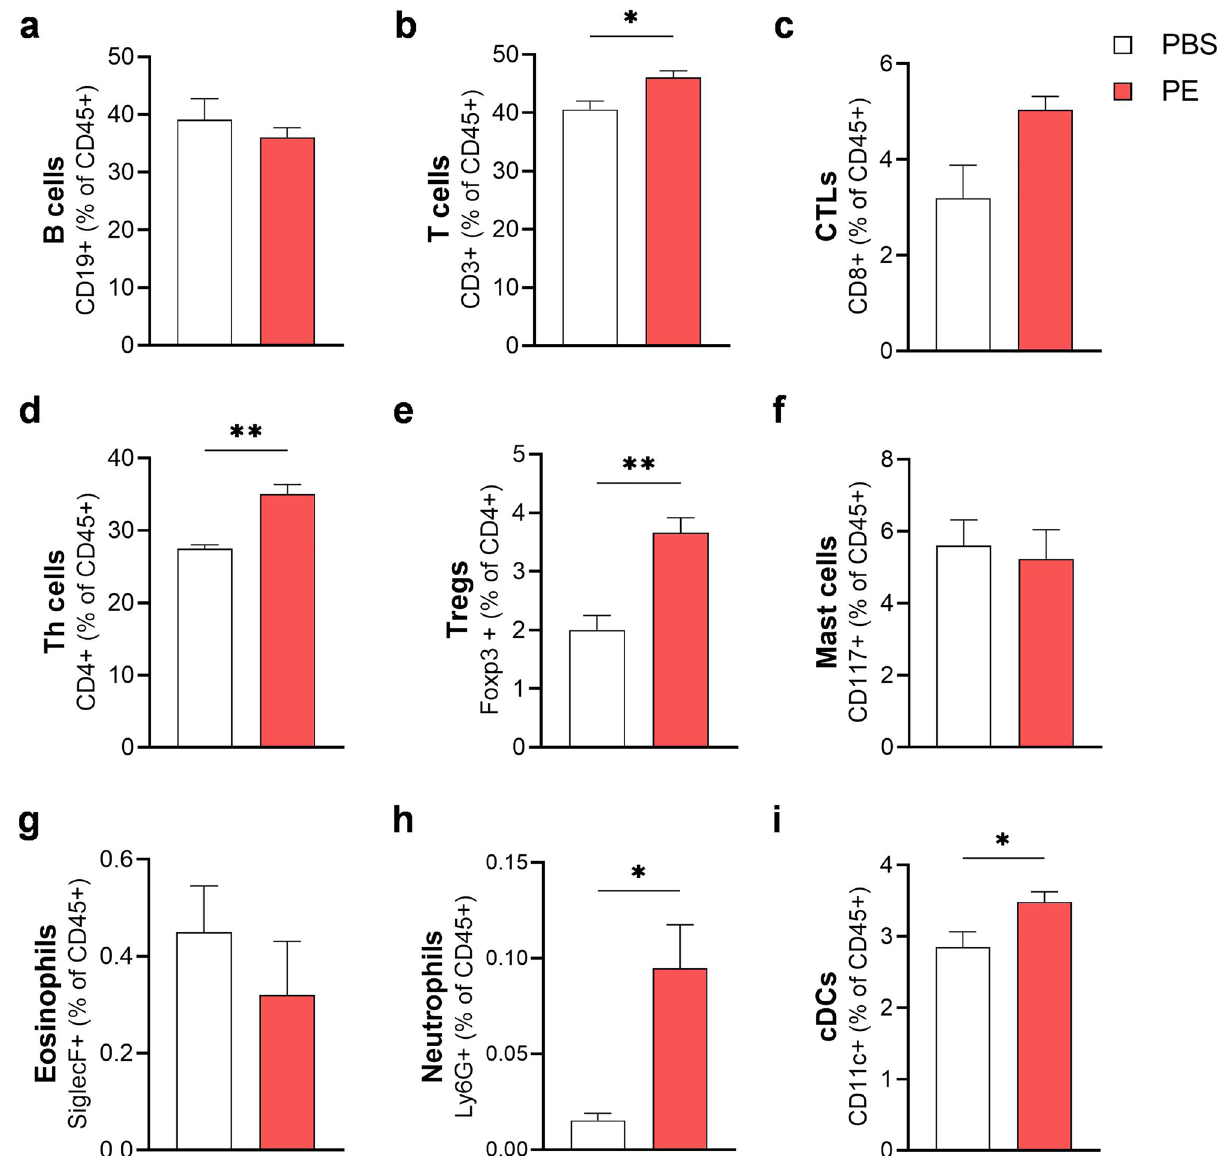
Figure 5. Immunological responses in the small intestine. The small intestine was enzymatically treated and isolated lamina propria immune cells were analyzed via flow cytometry. ( a ) B cells (CD45 + CD19 + cells), ( b )